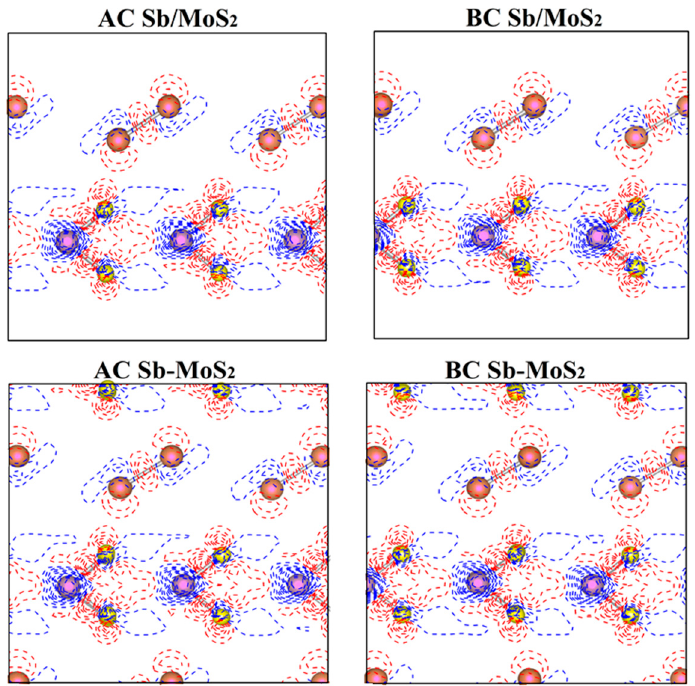
Figure 3. Deformation charge density ( ( ) r ρΔ ) for hybrid systems of planes perpendicular to the atomic layers and passing through Mo-S and Sb-Sb bonds. The red solid line and the blue dashed line indicate ( ) r ρΔ > 0 and ( ) r ρΔ < 0, respectively.